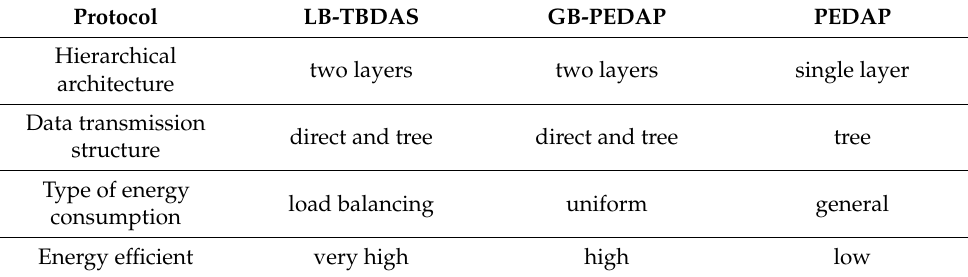
Table 2. The comparisons of LB-TBDAS, GB-PEDAP, and PEDAP.